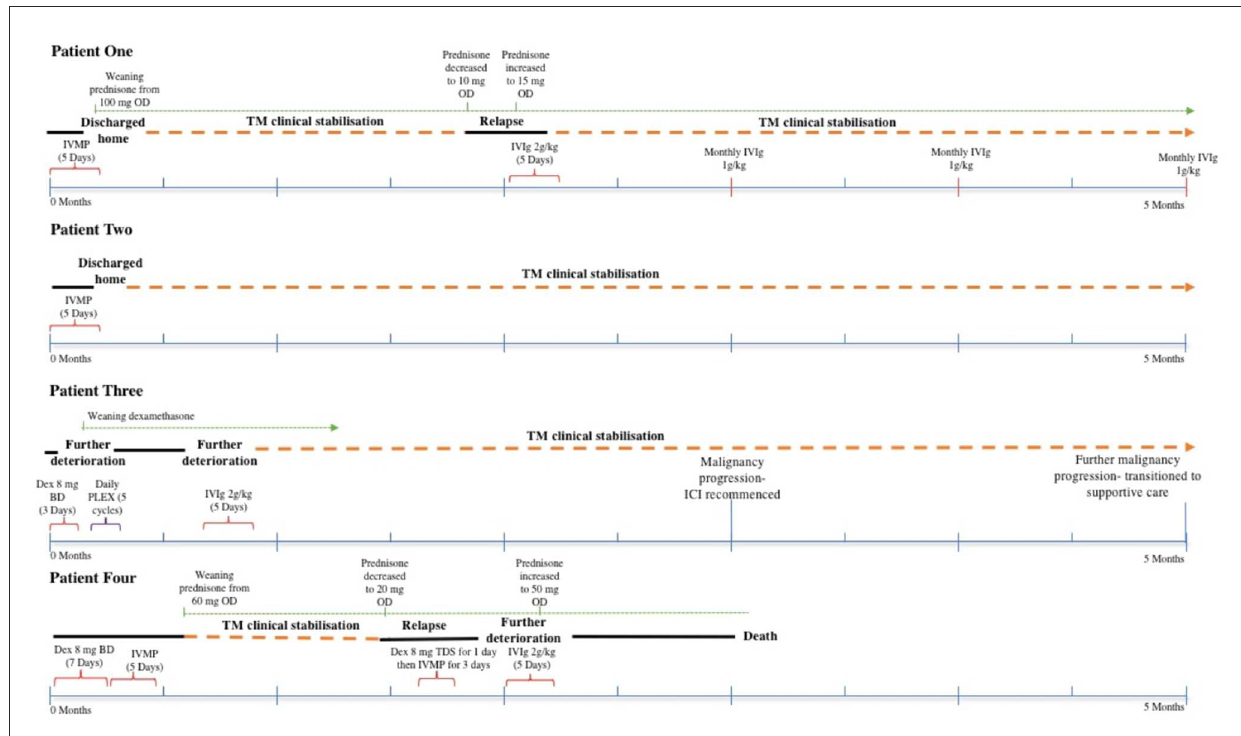
FIGURE2 Timeline of each patient presented (IVMP, intravenous methylprednisolone; OD, once daily; TM, transverse myelitis; IVIg, intravenous immunoglobulin; BD, twice daily; PLEX, plasmapheresis; ICI, immune checkpoint inhibitor; TDS, three times daily).